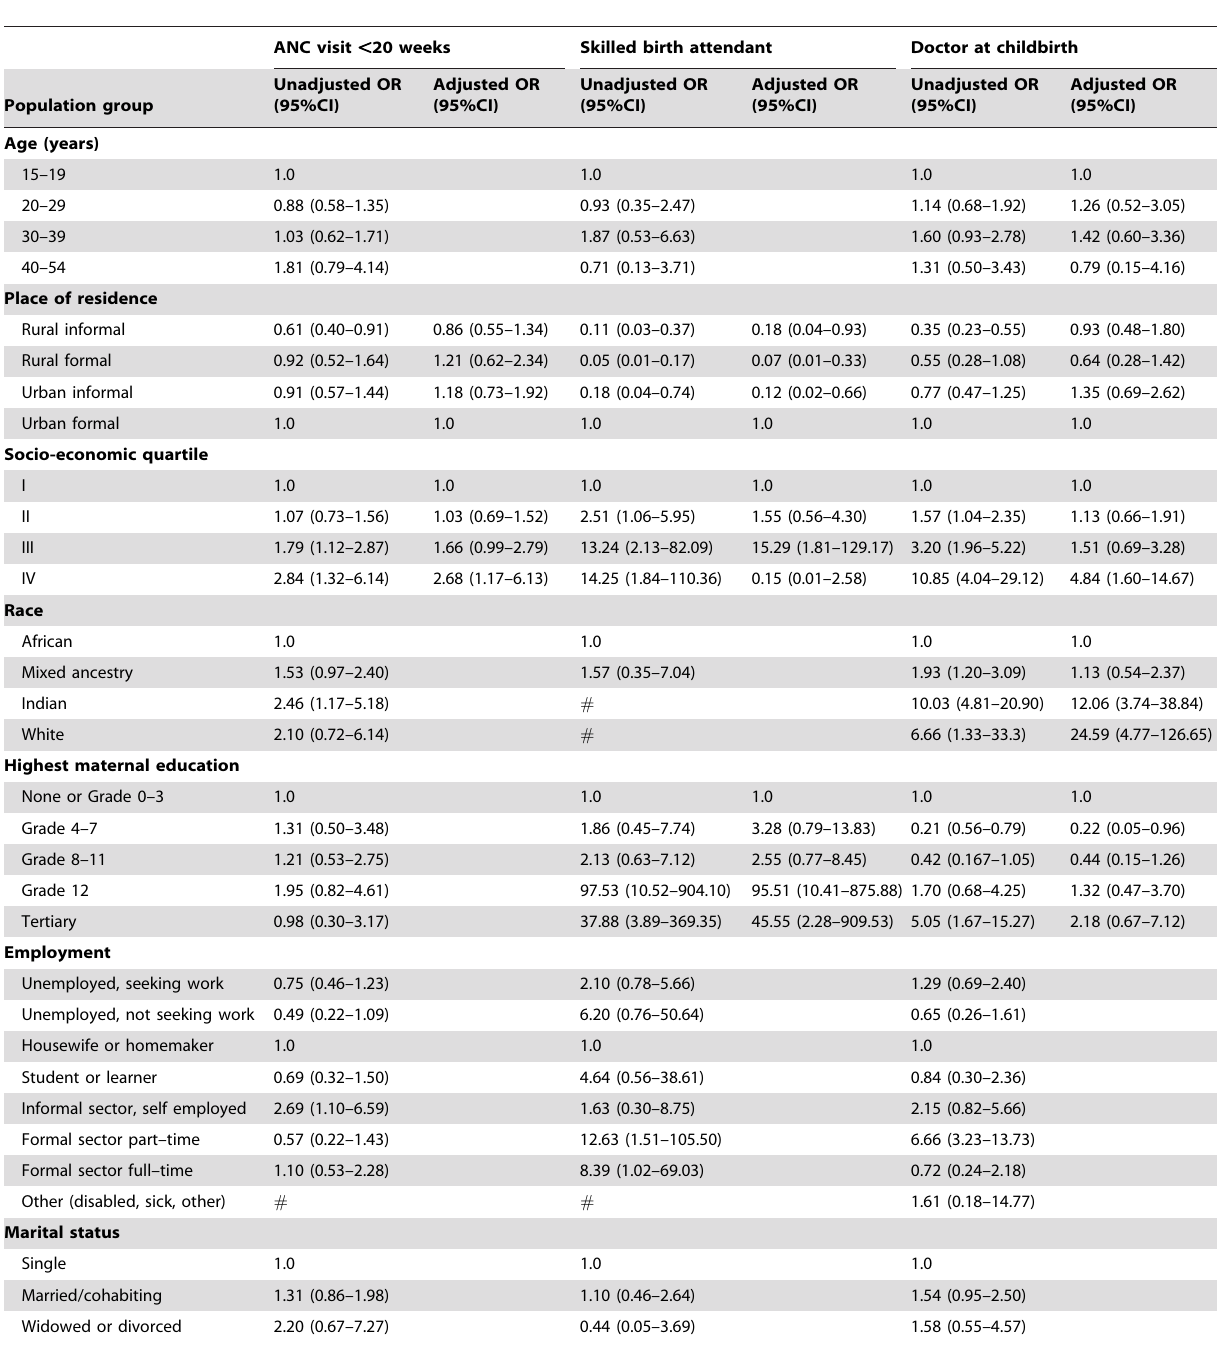
Table 3. Multivariate logistic regression analysis of factors associated with access to maternal health services in South Africa: Early antenatal attendance, skilled birth attendance and having a doctor present at